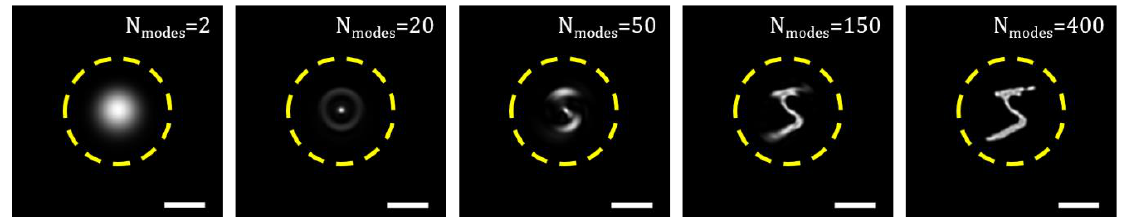
Figure 3. Decomposition of images in cases of different numbers of supported fiber modes. The size of the input images was approximately 100 × 100 pixels.